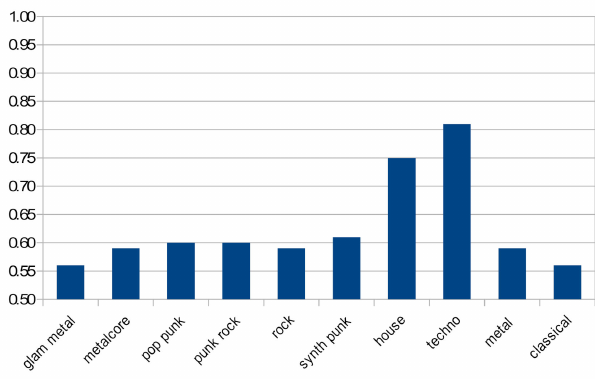
Figure 4. Mean values of root-mean-square energy (RMS energy) for music genres.